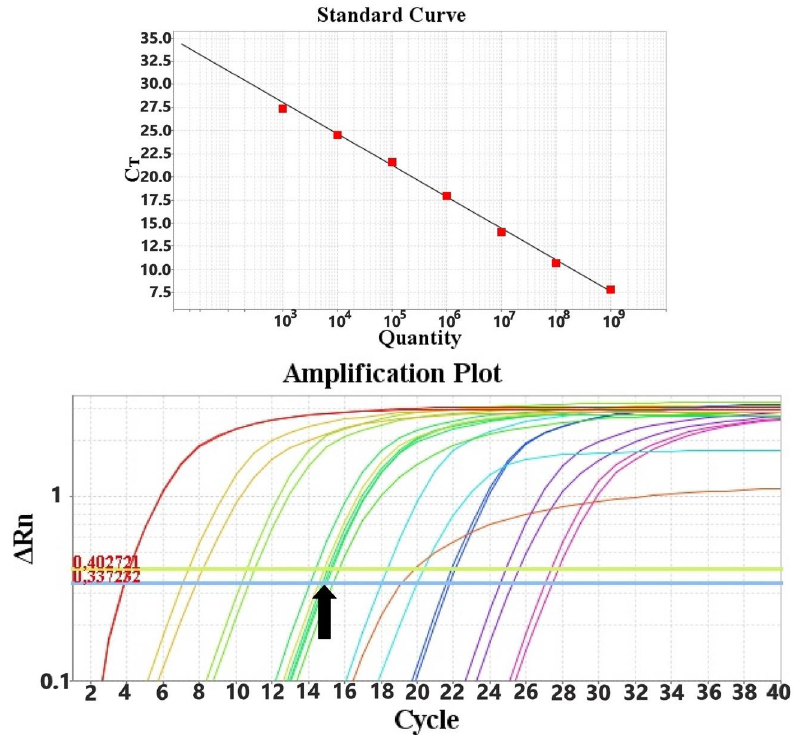
Figure 5. qPCR standard curve using PCV-2_Set_1 primer set, which targets the capsid protein gene, and amplification plot with reference and field samples indicated with the black arrow.